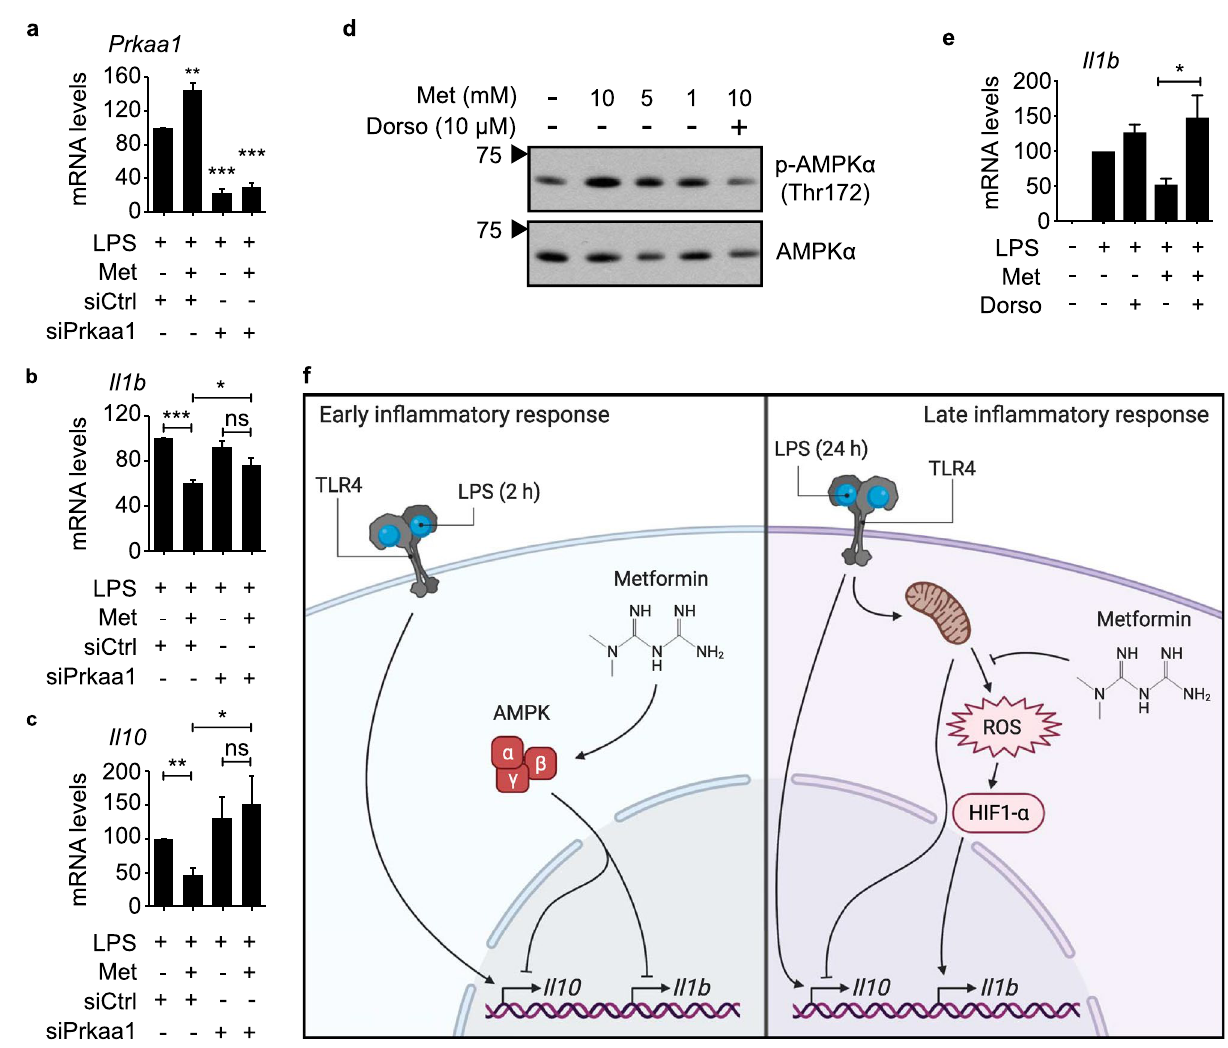
Figure 2. Metformin alters transcript levels during the acute LPS response by activating AMPK. ( a–c ) RT-qPCR with RNA from RAW 264.7 cells, quantifying expression of the indicated genes. Cells were transfected with siRNA targeting Prkaa1 (siPrkaa1) or a control siRNA (siCtrl), pretreated or not with 5 mM metformin (Met) for 6 h, and stimulated with 100 ng/ml LPS for 2 h. Rplp0 served as reference gene. ( d ) Western blot of lysates from primary BMDMs treated with metformin (Met) and dorsomorphin (Dorso) for 6 h, probing for phospho-AMPKα (Thr172) and total AMPKα. Black arrows indicate molecular weight in kDa. Images were cropped. See Supplementary Fig. S1j,k for full lanes. ( e ) RT-qPCR with RNA from J774 cells, quantifying expression of Il1b . Cells were pretreated with 5 mM metformin (Met) and/or 10 μM dorsomorphin (Dorso) for 6 h, followed by stimulation with 100 ng/ml LPS for 2 h. Tubb5 served as reference gene. ( f ) Model of the mechanism through which metformin affects the inflammatory response of macrophages. During the early phase, metformin reduces the transcription of Il1b and Il10 by activating AMPK (left panel). During the late phase, metformin reduces the production of ROS by mitochondria, which limits protein levels of HIF1-α and results in decreased expression of Il1b , whereas expression of Il10 is enhanced (right panel). p-values: ***p < 0.001; **p < 0.01; *p < 0.05; ns not significant. Error bars indicate standard error of 5